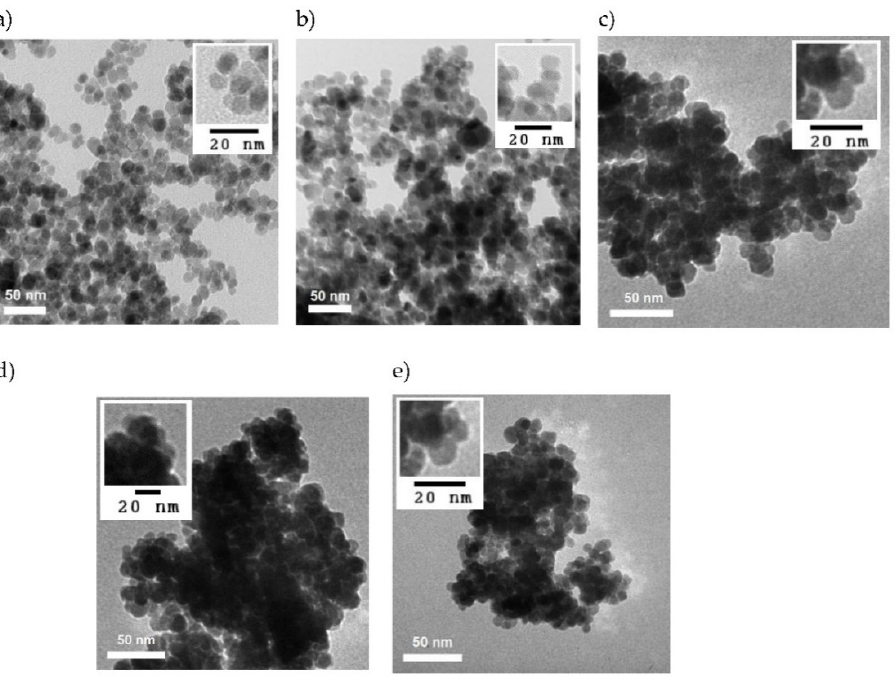
Figure 2. TEM images of ( a ) Fe 3 O 4 , ( b ) Fe 3 O 4 @1%Zn, ( c ) Fe 3 O 4 @2%Zn, ( d ) Fe 3 O 4 @5%Zn, and ( e ) Fe 3 O 4 @10%Zn.